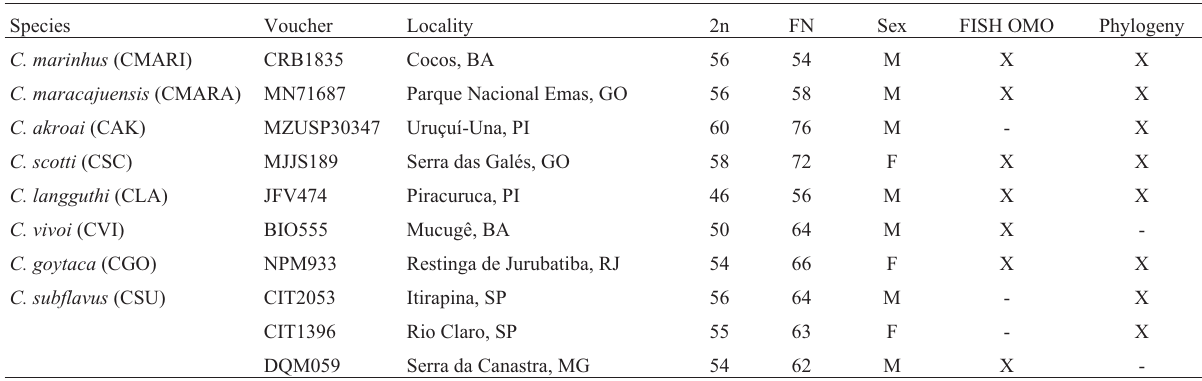
Table 1 - Specimens analyzed in this